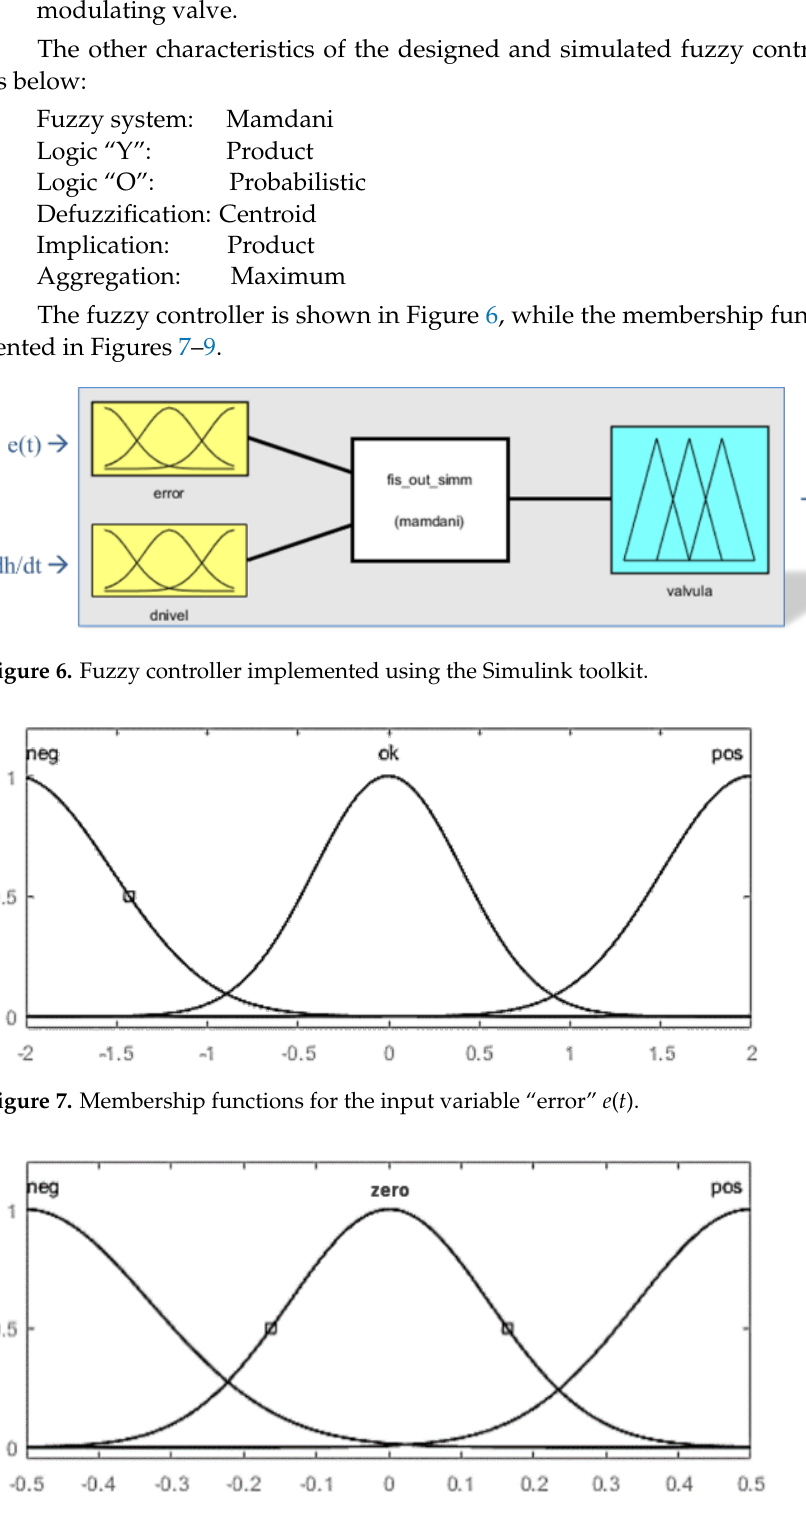
Figure 8. Membership functions for the input variable “dnivel” ( dh / dt ).